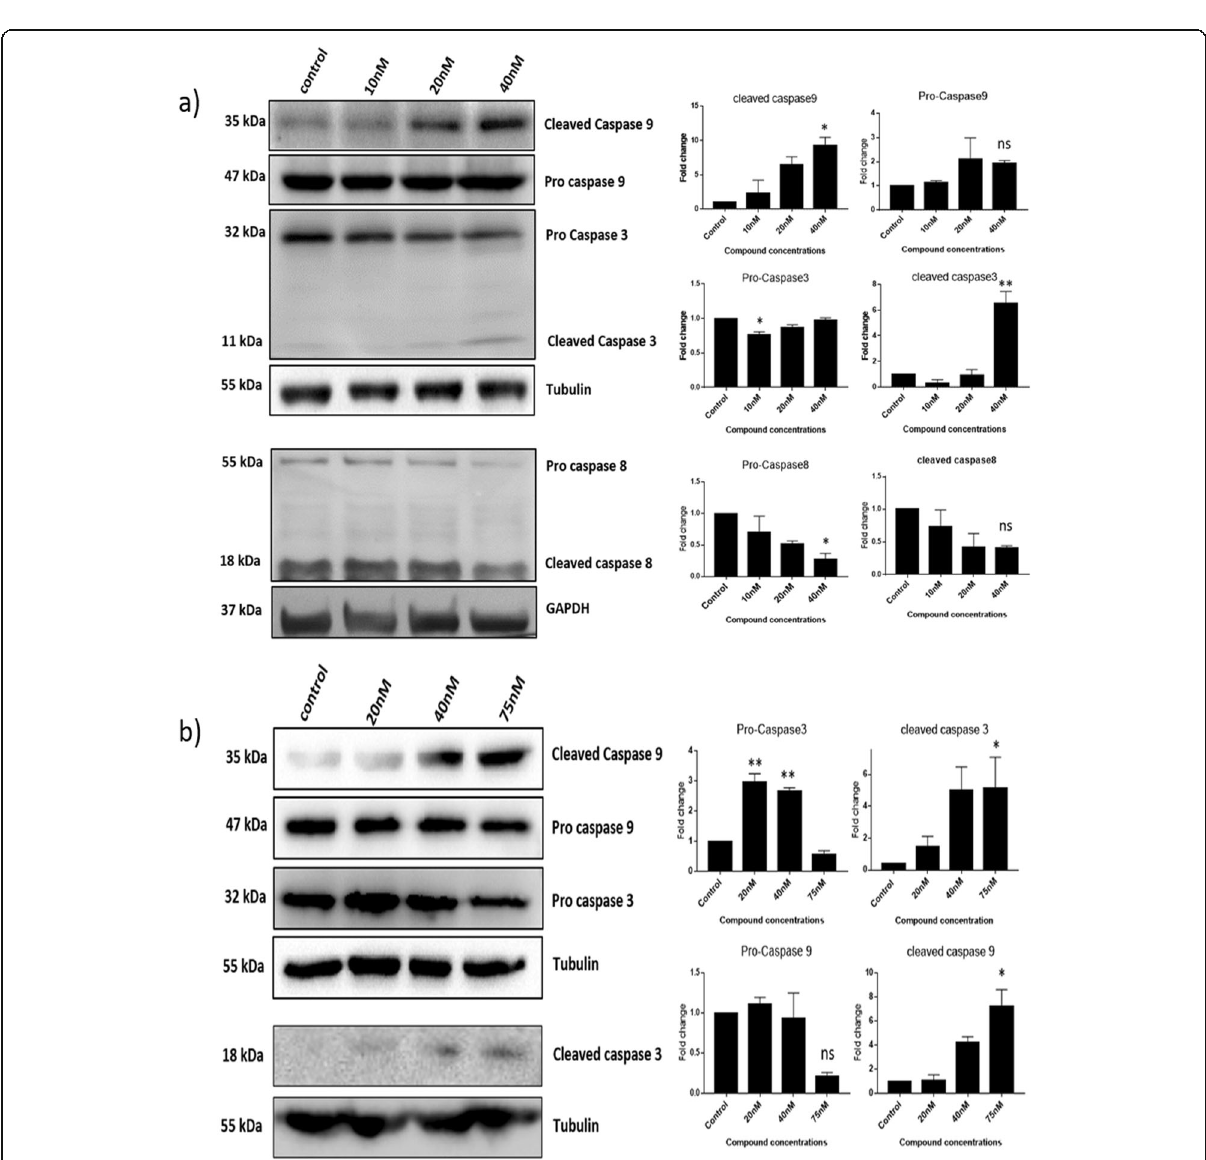
Fig. 6 Expression of apoptotic proteins PA1 and MDA-MB-231 cells on compound treatment. a Western blot image of PA1 cell lysate treated with ST03 compound for 48 h b Western blot image of MDA-MB-231 cell lysate treated with ST08 compound for 48 h. Each experiment was repeated for a minimum of 3 times and plotted as bar graphs with error bars. One way ANOVA was conducted and the p value was calculated between control and ST03 treated groups, where, *: p value < 0.05, **: p value <